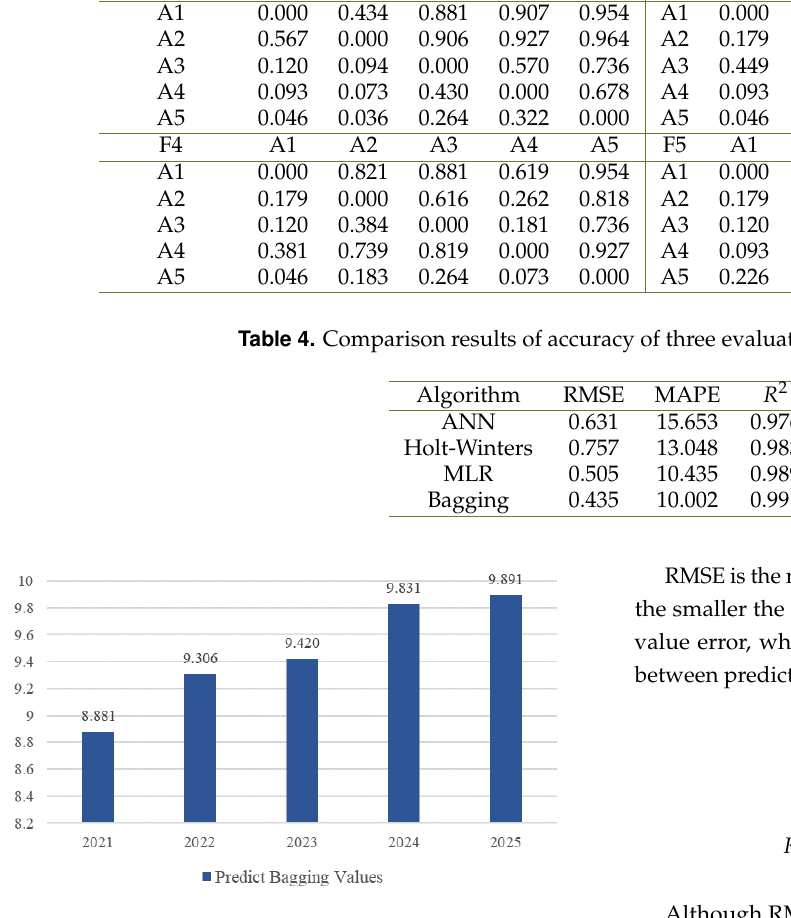
Fig. 8. Results of integrated learning prediction in the next 5